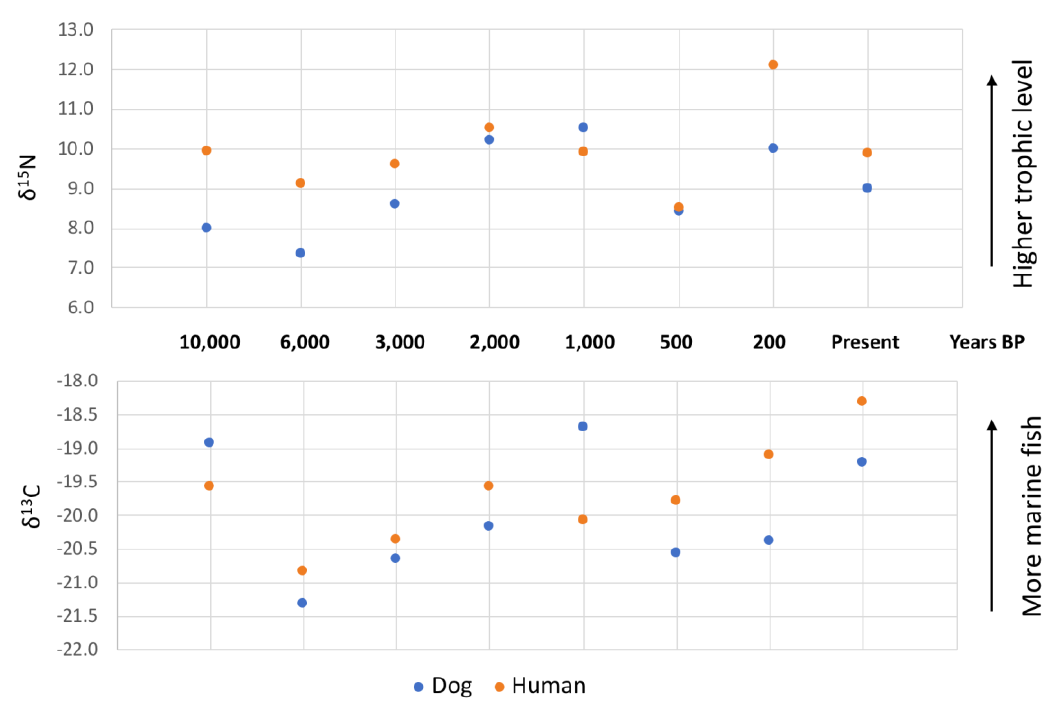
Figure 2. A diagram demonstrating the long-term history of the shifting isotopic values that reflect human and dog diets in Britain over the last 10,000 years. The parallel shifts in the carbon and nitrogen values between both species suggests a closeness of the human-dog relationship over the past 10 millennia